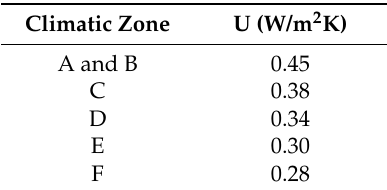
Table 1. Thermal transmittance values for opaque components (e.g., infill panels) according to